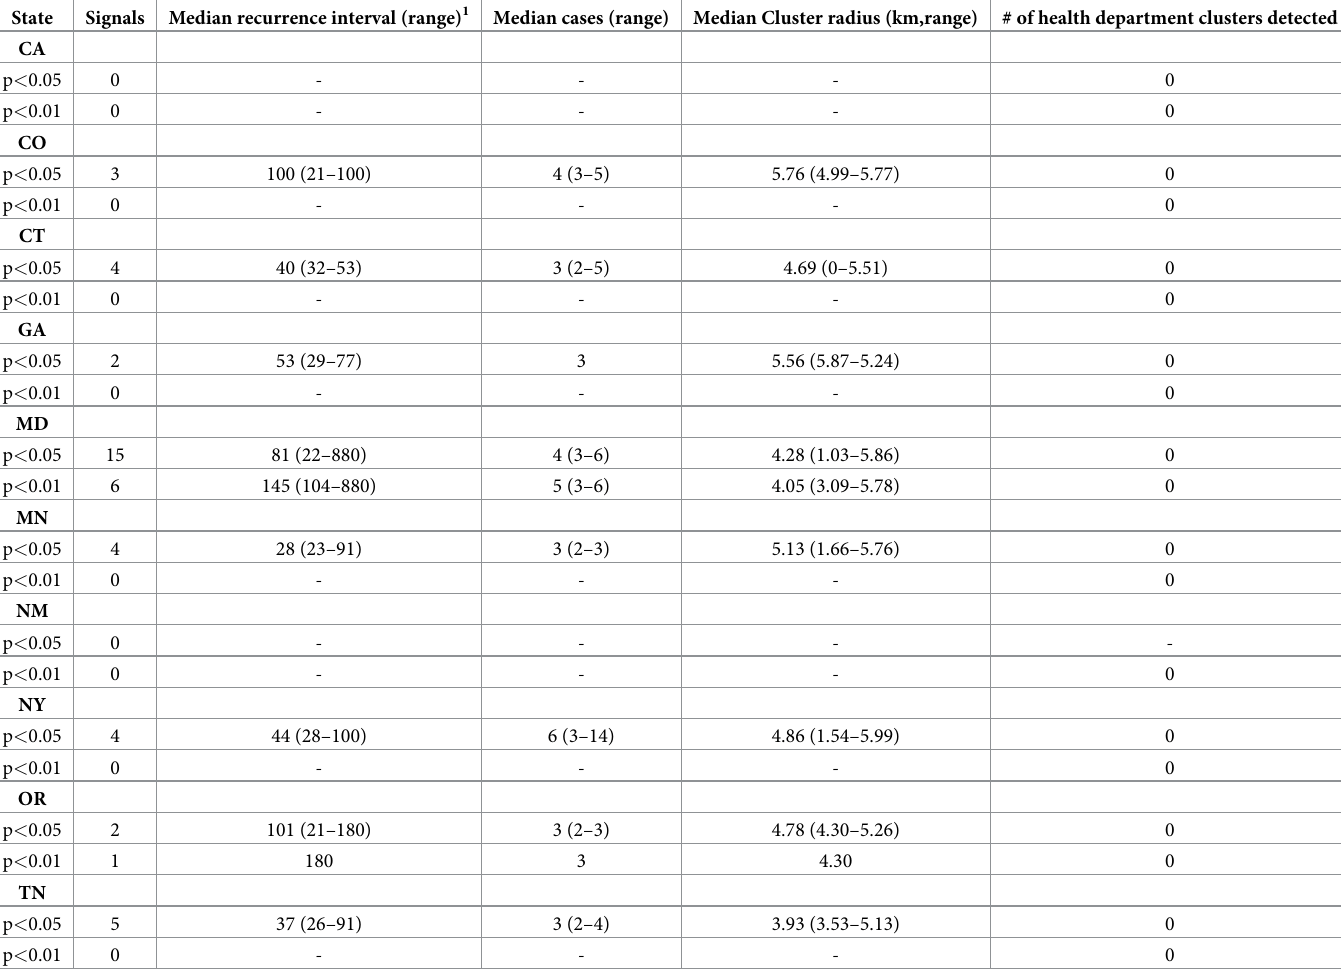
Table 3. Signals detected by prospective SaTScan